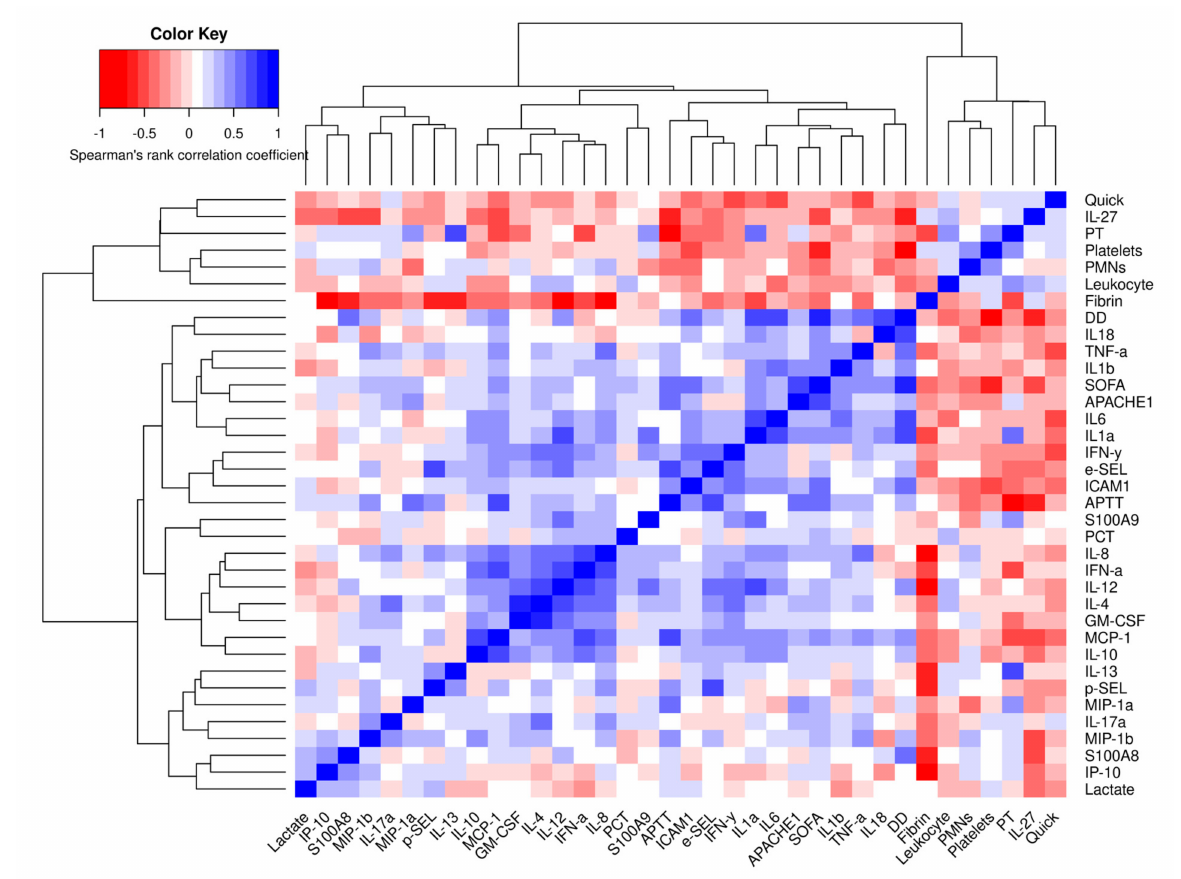
Figure 7. Hierarchical cluster representing the Spearman’s rank correlation coefficients ( − 1 to +1) among the clinical and analytical variables measured. Red color indicates a negative correlation and blue color indicates a positive correlation between compared parameters. The dendrograms were obtained by hierarchical clustering using the complete linkage method. Clusters of the dendrograms include cytokines, reactants, endothelial mediators and clinical features with a strong positive correlation. APACHE II: Acute Physiology and Chronic Health disease Classification System II; SOFA: Sequential [Sepsis-related] Organ Failure Assessment; APTT: activated partial thromboplastin time; DD: D-Dimer; PT: prothrombin time; PMNS: polymorphonuclear cells. The number of subjects analyzed were as follows: control ( n = 10); intensive care unit (ICU) ( n = 5); sepsis ( n = 10); septic shock (SS) ( n =